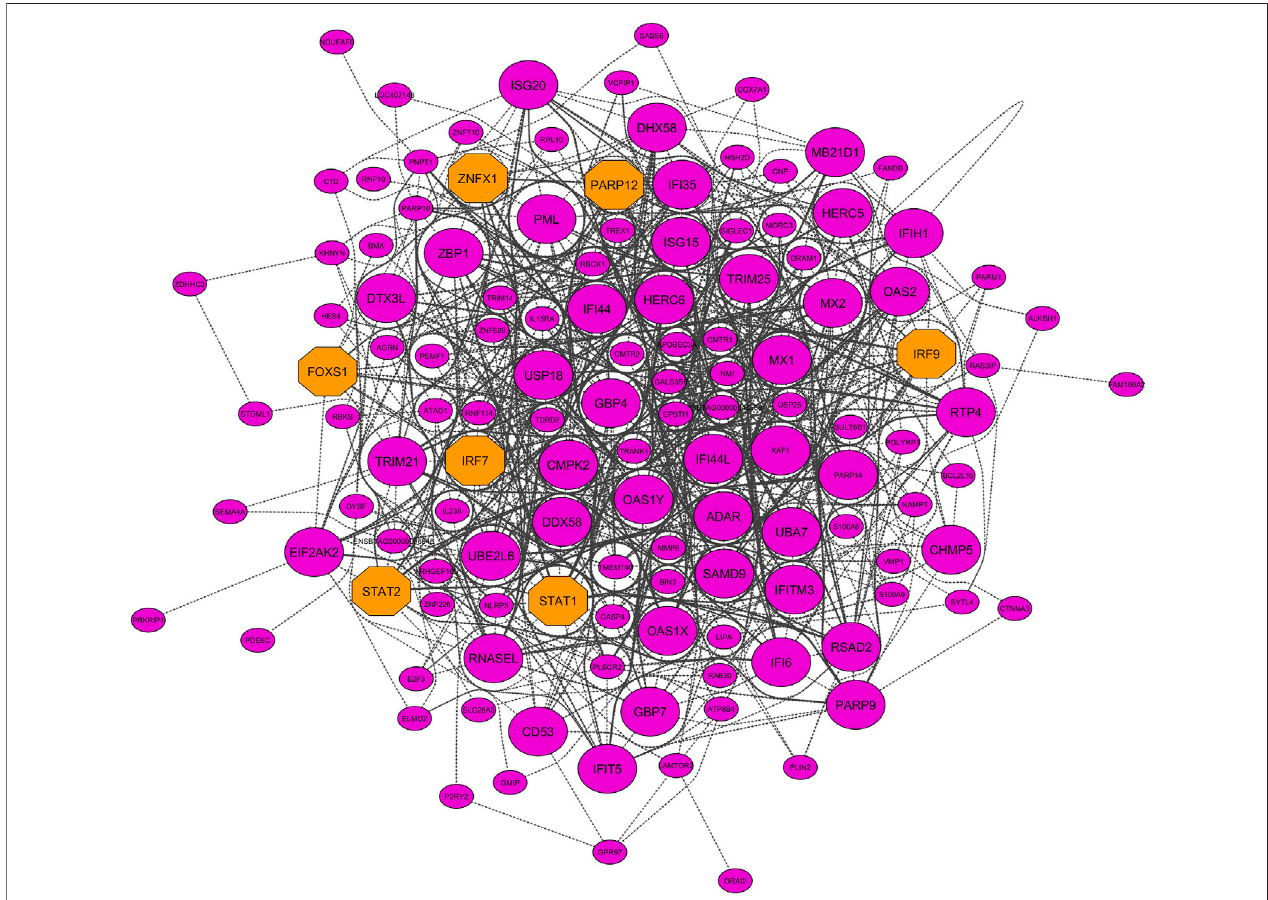
FIGURE 8 | PPI network based on the hub genes of the purple module (identi fi ed by module preservation method). Larger nodes and orange octagons represent hub – hub genes and transcription factors, respectively.